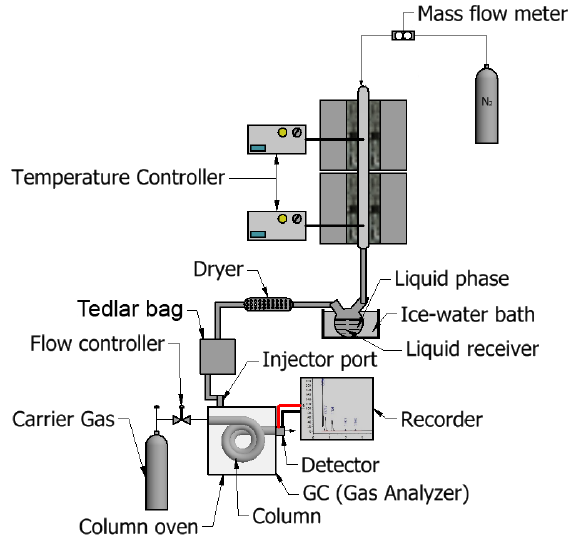
Figure 2. The scheme of the fixed-bed vertical reactor and gas analyser.